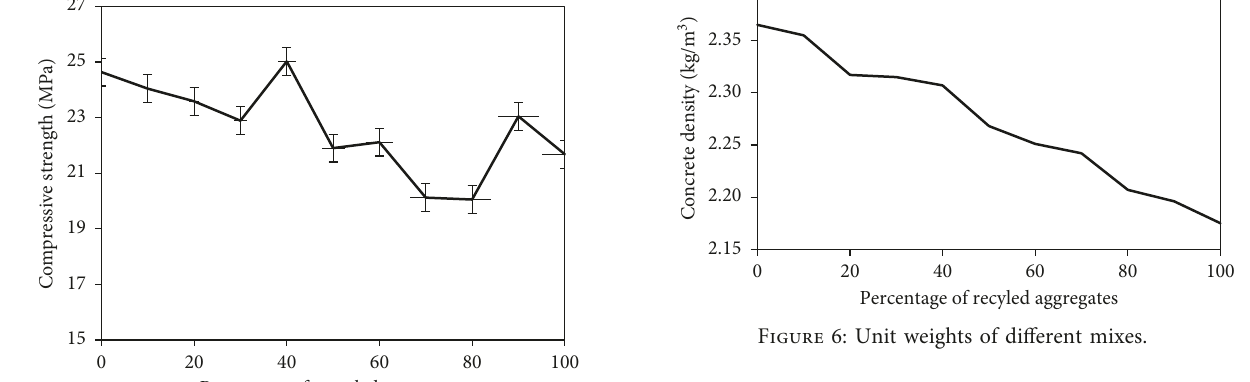
Figure 5: Dry densities of natural and recycled aggregates. coarse aggregates. ″